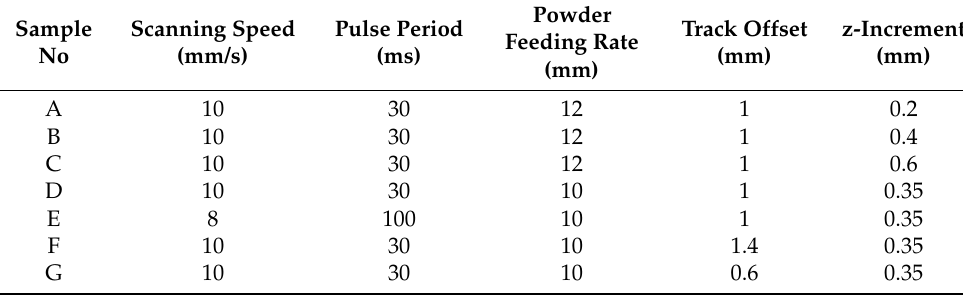
Figure 1. ( a ) Morphology of Inconel 718 alloy powder. ( b ) Experimental setup. ( c ) Schematic diagram of pulsed laser. ( d ) Scanning strategy. Table 1. Processing parameters of